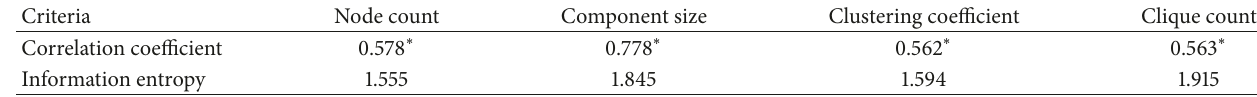
Table 1: Extracted measures for Al-Qaeda Networks.